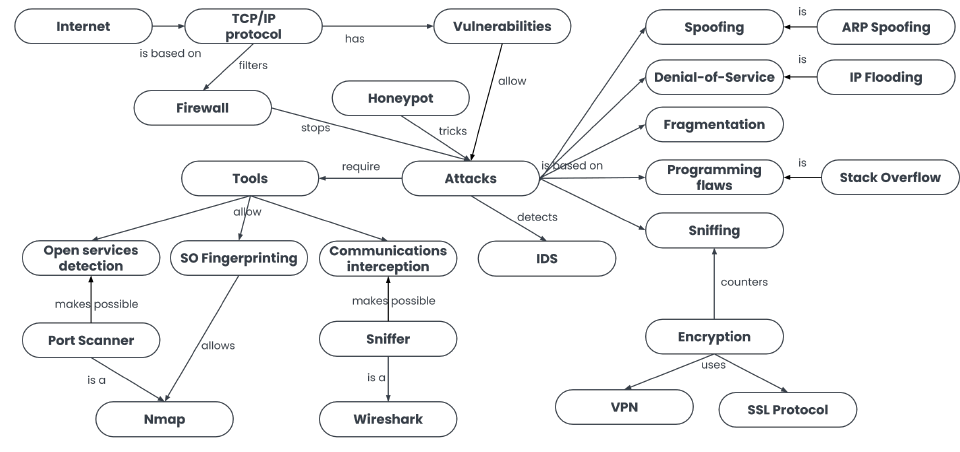
Figure 2. Novelette conceptual